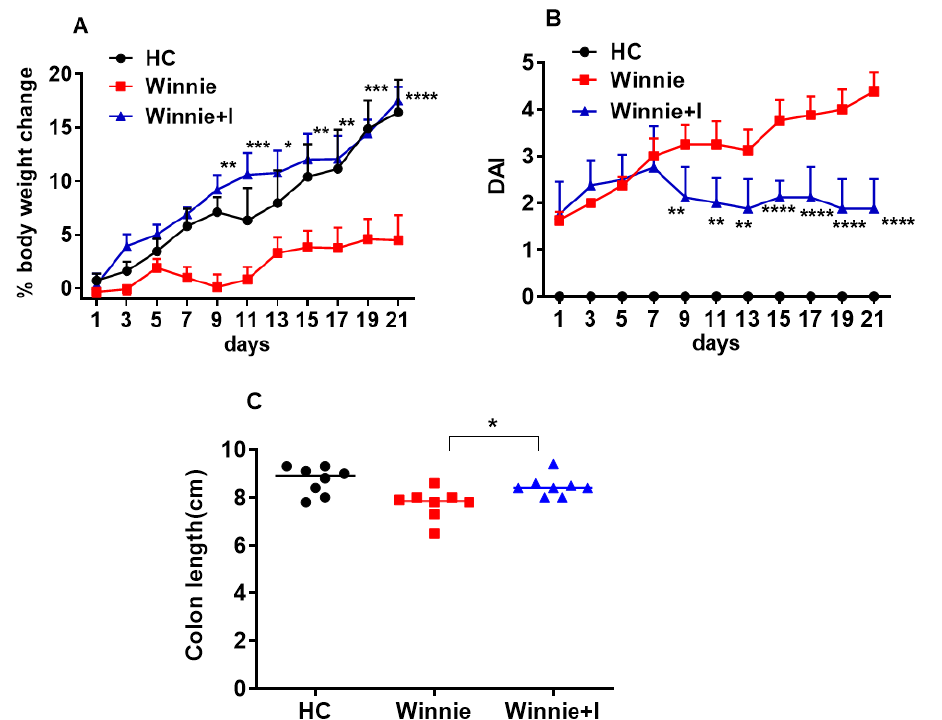
Figure 1 . Effect of idebenone on the clinical symptoms of spontaneous chronic colitis. ( A ) % body weight change, ( B ) Disease Activity Index (DAI) and ( C ) Colon length. Data expressed as mean ± SEM ( n = 8/group). Statistical significance among groups evaluated by Two-way ANOVA followed by Bonferroni’s post-test. * p < 0.05 , ** p < 0.01 *** p < 0.001 and **** p < 0.0001 vs Winnie. Colon length